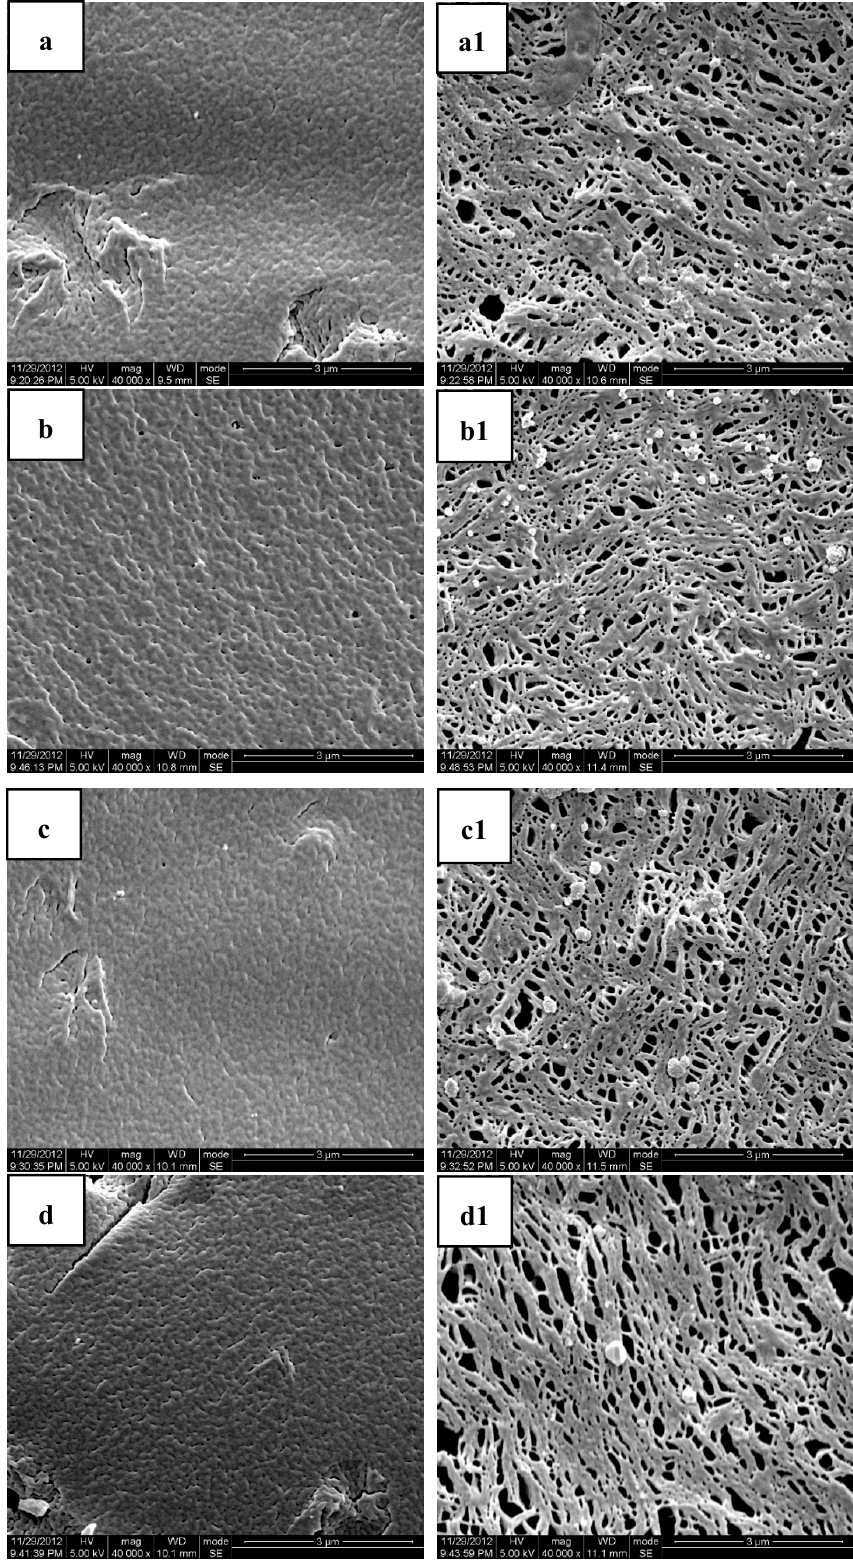
Figure 6. SEM photos of the cryofractured cross sections and molded surfaces of PLA / PEG / MB samples